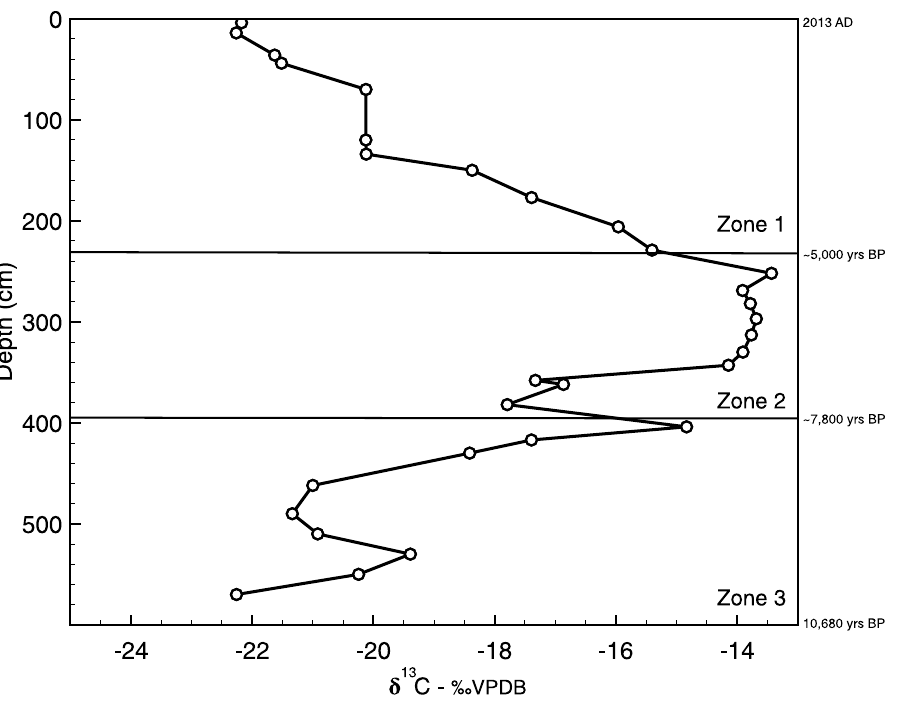
Fig 2. TOC isotope values ( δ 13 C TOC ) versus depth in the Lake Harris core. The three zones in the core are delineated by major shifts in δ 13 C TOC (shown in the figure as solid horizontal lines). Zone 3 is from 590 to 403 cm, zone 2 is from 402 to 241 cm, and zone 1 extends from 240 cm to the core